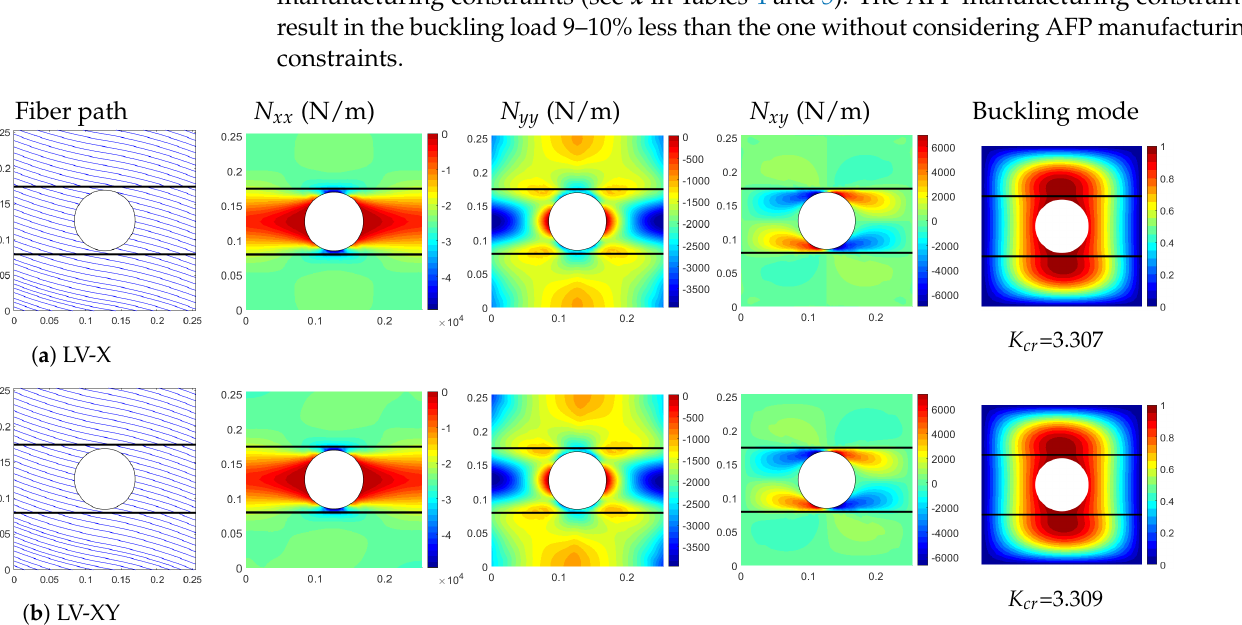
Figure 12. Comparison of optimal fiber paths, stress resultants, and buckling modes for different study cases of the stiffened VAT laminates with a central hole under uniform axial displacement considering AFP manufacturing constraints. ( a ) LV-X laminate design; ( b ) LV-XY laminate